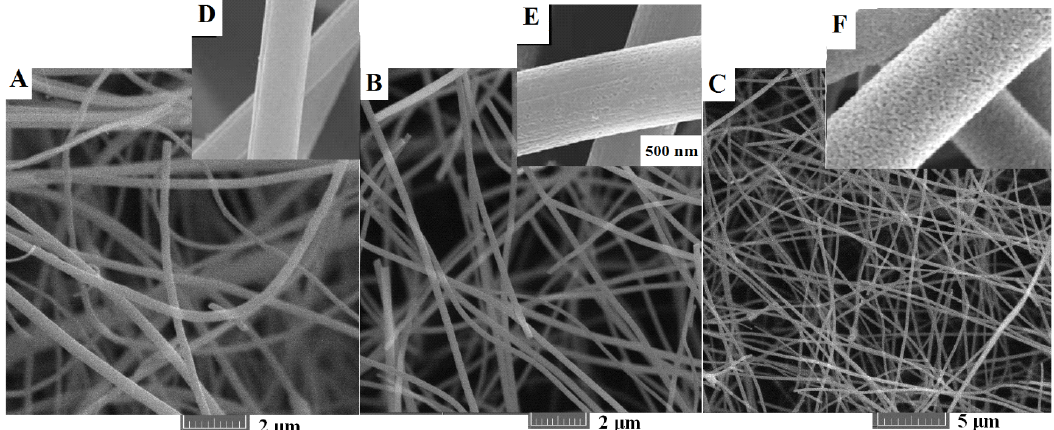
Fig. 3. SEM images of nanofibers with different concentrations of TiP (A-C) calcined at different temperatures. (D) 450 o C; (E) 650 o C; (F) 850 o